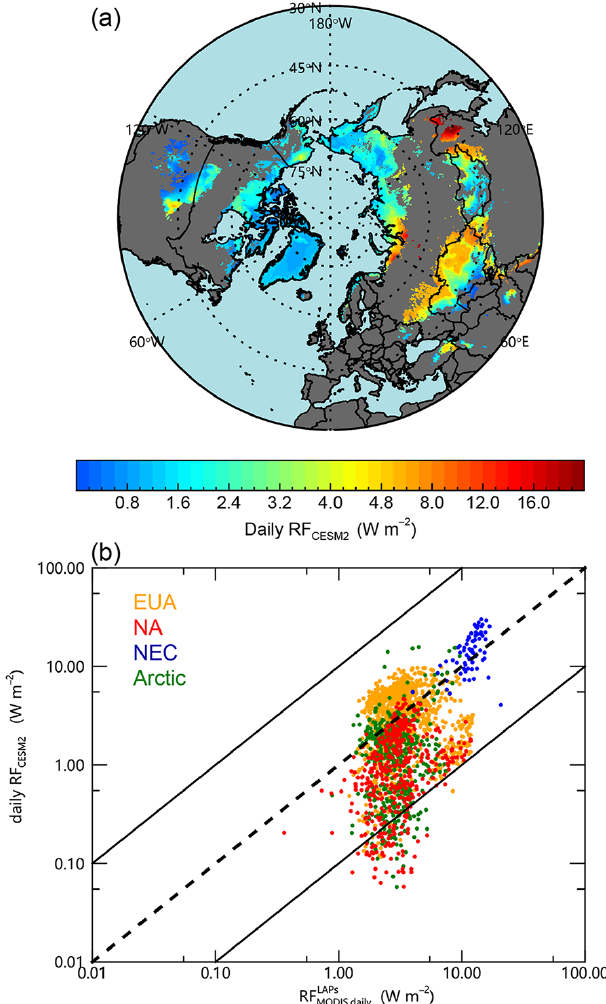
Figure 10. (a) Spatial distributions of daily average radiative forcing (RF CESM2 ) based on the CESM2 soot content of snow in December–May for the period 2003–2014. (b) Scatterplot of RF LAPs versus RF CESM2 MODIS,daily